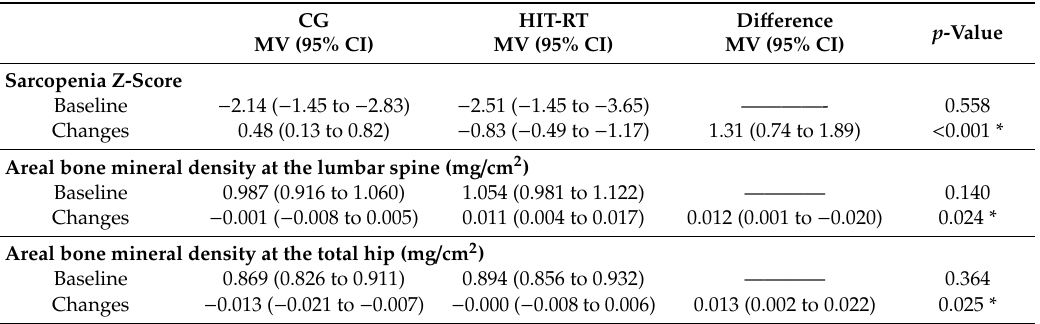
Table 2. Baseline data and changes in primary study endpoints in the high intensity resistance exercise training group (HIT-RT) versus the control groups (CG). MV (95%-CI): mean value (95%-confidence interval). * unadjusted p -values.